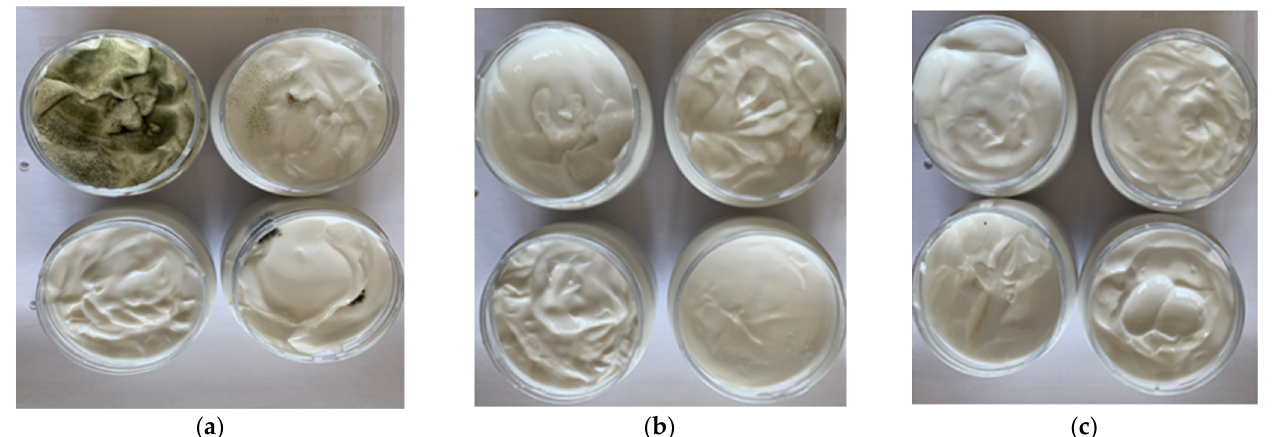
Figure 7. Persistency of emulsions with on different types of oils: ( a ) Refined olive oil; ( b ) Ozonated olive oil 0.04 mole O 3 /100 g oil; ( c ) Ozonated olive oil 0.10 mole O 3 /100 g oil.